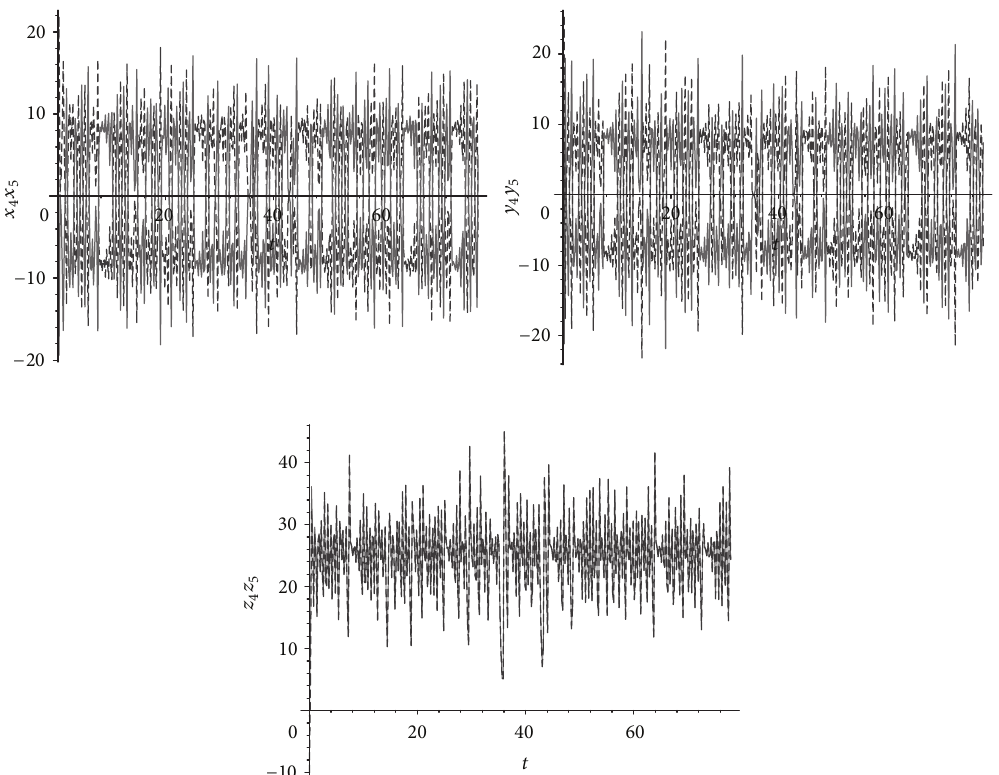
Figure 13: The temporal evolution of variables between node 4 (“ ⋅⋅⋅ ”) and node 5